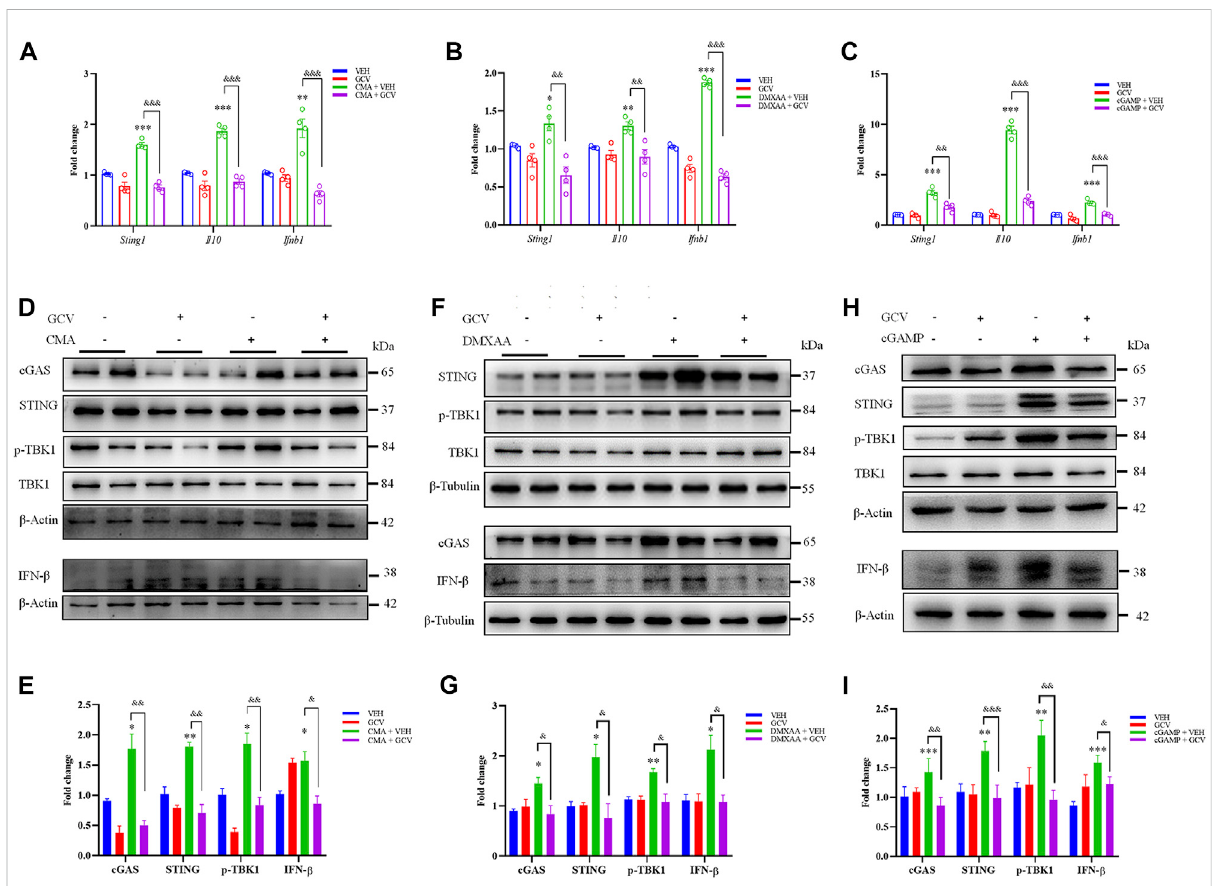
FIGURE 2 Low-dose GCV inhibited cGAS-STING pathways in RAW264.7 cells. (A – C) Q-PCR analysis showed the effect of pretreatment of GCV on up- regulation of mRNA expression of Sting1 , Il10 , Ifnb1 induced by CMA- (A) , DMXAA- (B) , and cGAMP (C) in RAW264.7 cells. (D) Western blotting analysis showedtheeffectofGCVonCMA-induced expressionchangesofcGAS,STING,IFN- β ,andp-TBK1inRAW264.7cells. (E) Statisticalanalysis results for (D) . (F) Western blotting analysis showed the effect of GCV on DMXAA-induced expression changes of cGAS, STING, IFN- β , and p-TBK1 in RAW264.7 cells. (G) Statistical analysis results for (F) . (H) Western blotting analysis showed the effect of GCV on cGAMP-induced expression changes of cGAS, STING, IFN- β , and p-TBK1 in RAW264.7 cells. (I) Statistical analysis results for (H) . ( n = 4 each group, * p < 0.05, ** p